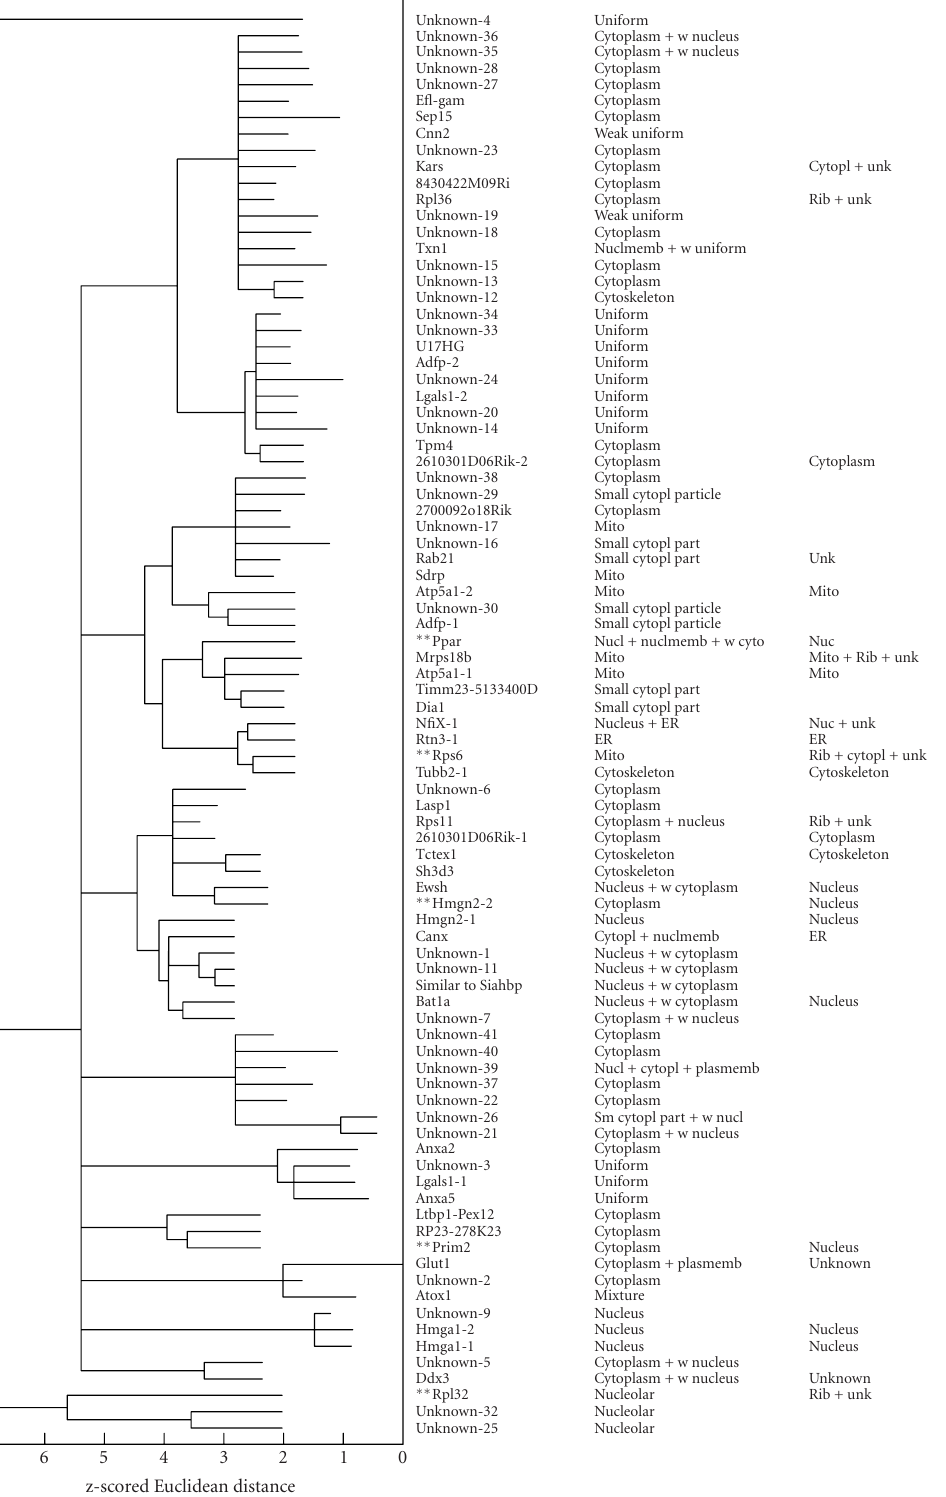
Figure 4. A consensus subcellular location tree generated on the 3D 3T3 image dataset using SDA-selected 3D-SLF11 features. The columns show the protein names (if known), human observations of subcellular location, and subcellular location inferred from gene ontology (GO) annotations. The sum of the lengths of horizontal edges connecting two proteins represents the distance between them in the feature space. Proteins for which the location described by human observation di ff ers significantly from that inferred from GO annotations are marked ( ∗∗